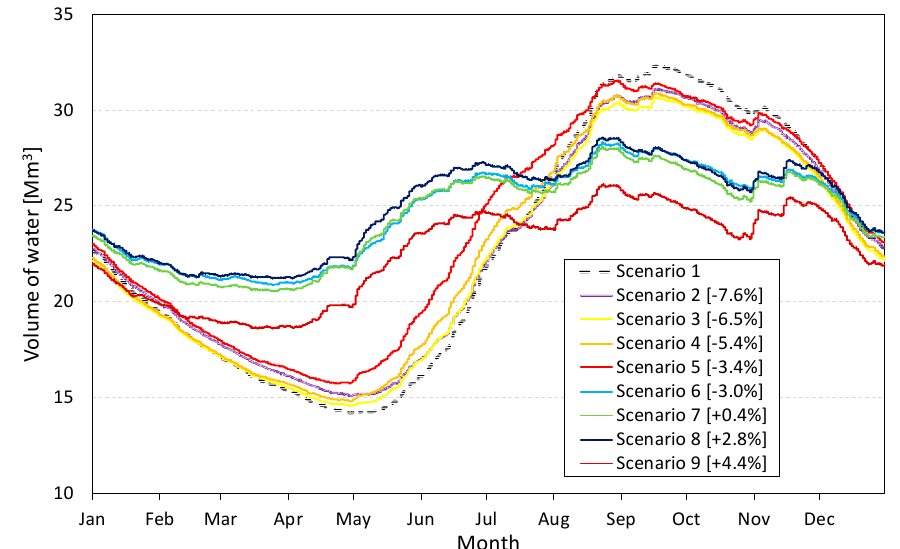
Figure 7. Evolution of the reservoir’s volumes for the nine climate scenarios at 2030.The mean income variation w.r.t to base climate scenario 1 are provided in the brackets, with a 95% confidence interval.